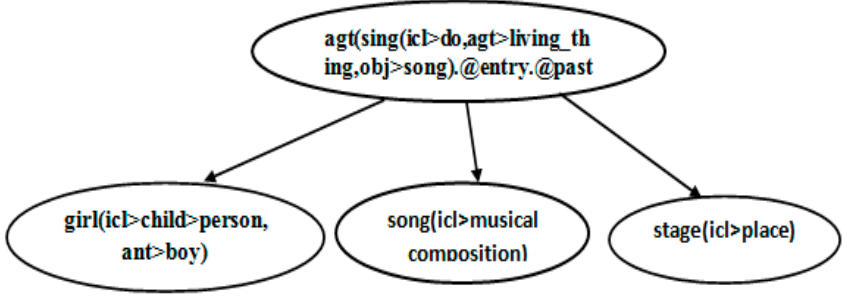
Figure 3. UNL graph generated by the parser for the input UNL expression.